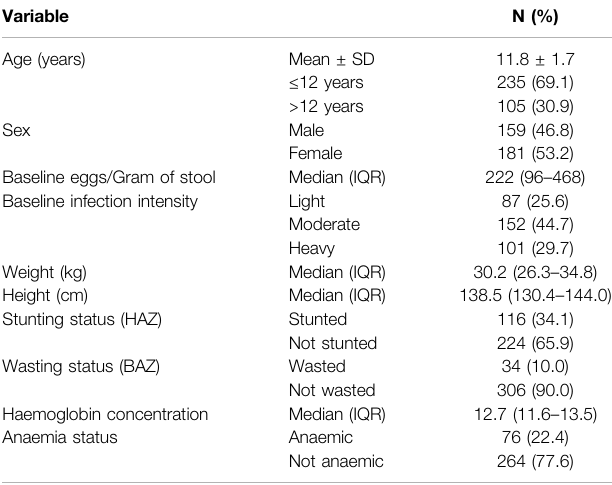
TABLE 1 | Baseline characteristics of the studied population. Variable